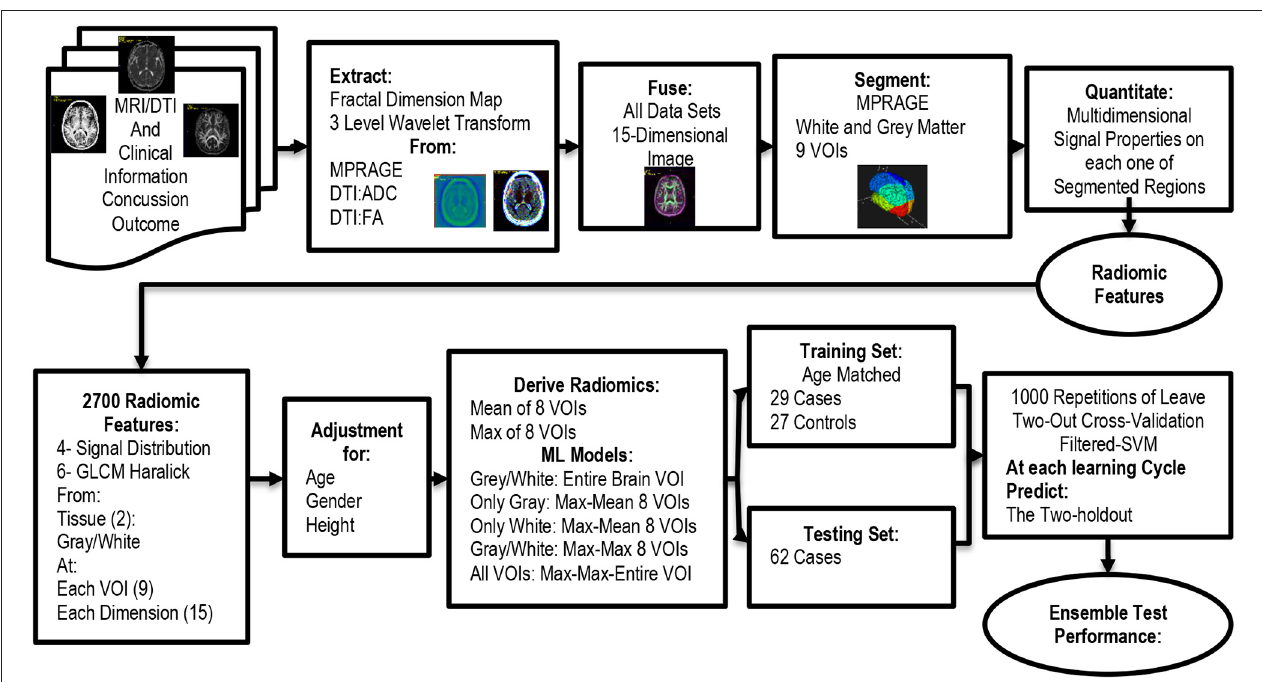
FIGURE 2 | Flowchart for the analysis of the procedure used for the association analysis.